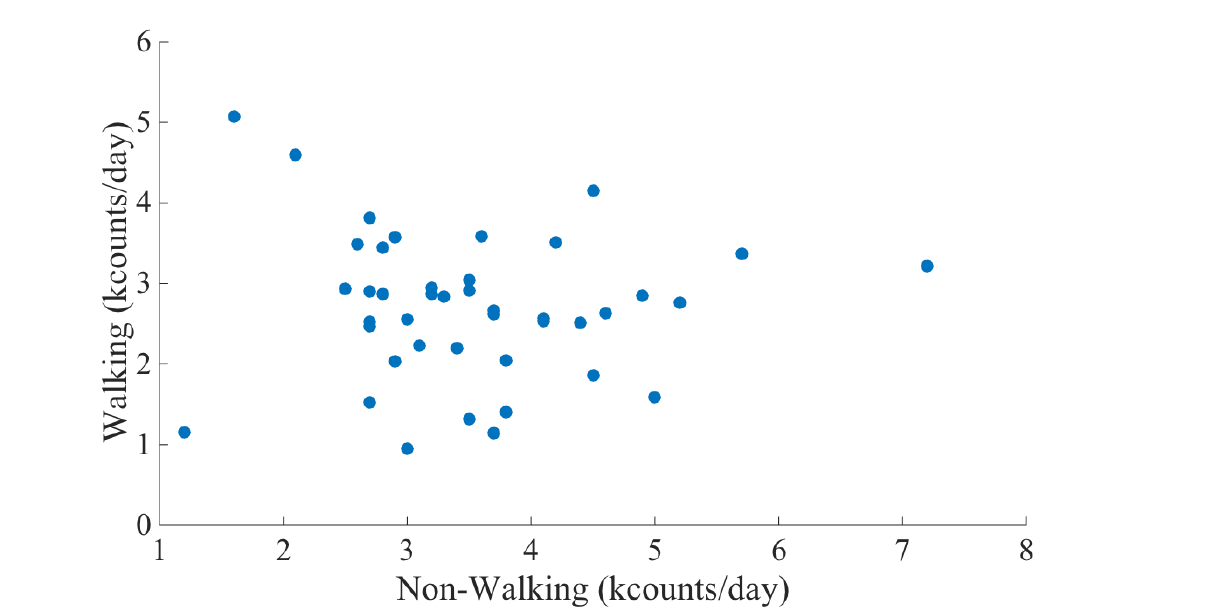
Figure 3. Walking counts versus nonwalking counts in older subjects